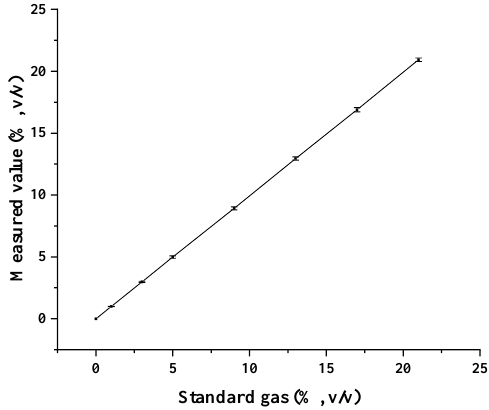
Figure 2. Oxygen concentrations of the mixed gases with high-purity nitrogen and oxygen in different proportions for equipment stability testing.